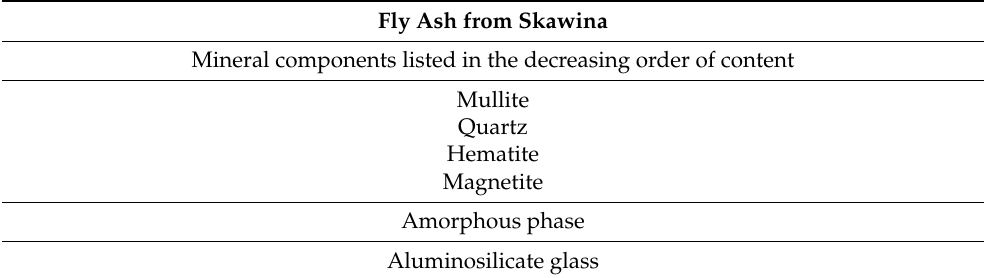
Table 4. Phase composition of the Skawina charcoal fly